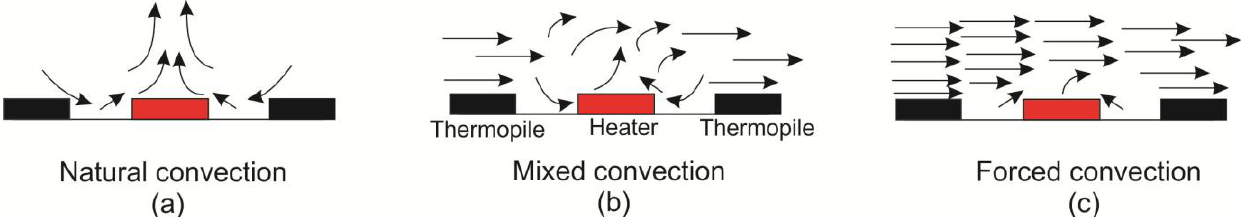
Figure 1. Representation of natural, mixed, and forced convections around thermal flow